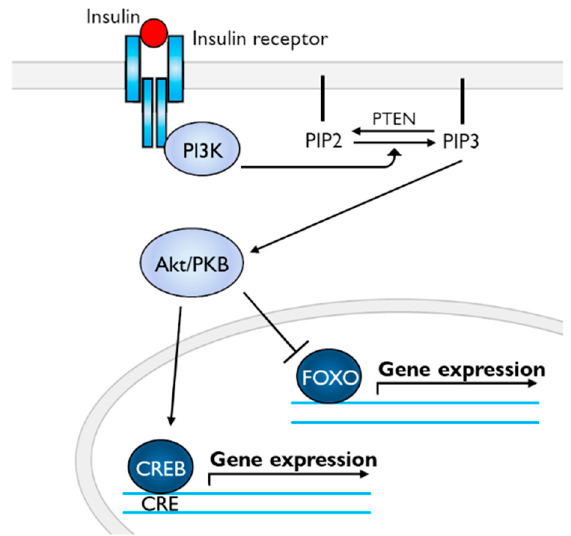
Figure 4. Scheme of deduced insulin-signaling cascades for memory enhancement. Akt/PKB phosphorylates CREB (i.e., CREB1 in Lymnaea ), resulting in gene expression, whereas Akt/PKB phosphorylates FOXO, inducing its secession from DNA. Abbreviations: PI3K, phosphoinositide-3-kinase; PIP2, phosphatidylinositol 4,5-bisphosphate; PIP3, phosphatidylinositol 3,4,5-trisphosphate; PTEN, phosphatase and tensin homolog deleted on chromosome 10 (i.e., PIP3 phosphatase); Akt/PKB, Akt/protein kinase B: CREB, cAMP response element-binding protein; FOXO, forkhead box O.